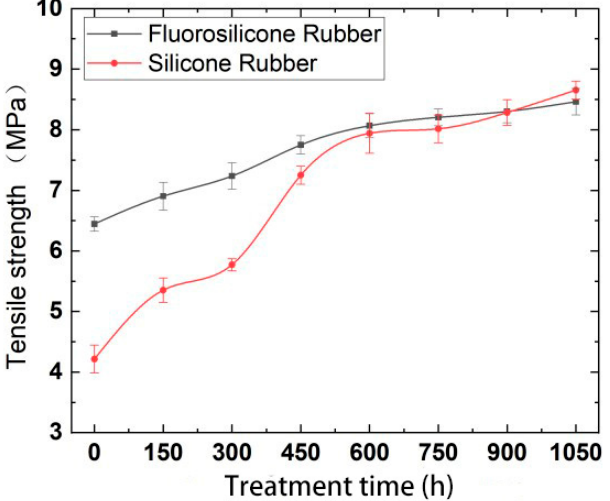
Figure 6. The variation of tensile strength with low temperature freezing time.